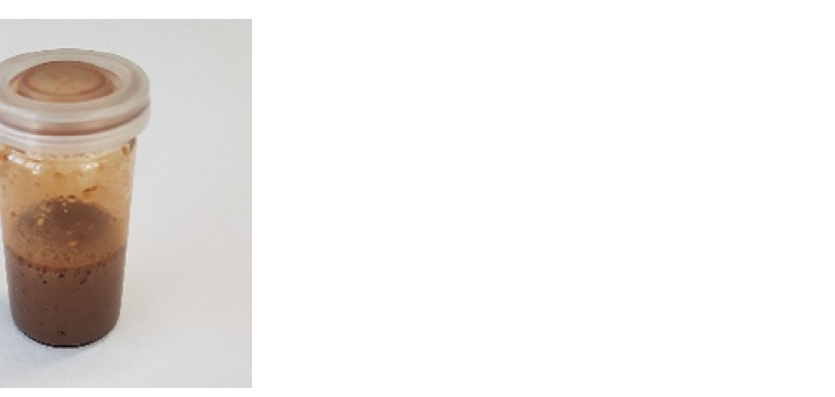
Figure A3. Alternative ferrofluid coated with oleic acid, polyethylene glycol and agar a few hours after preparation.